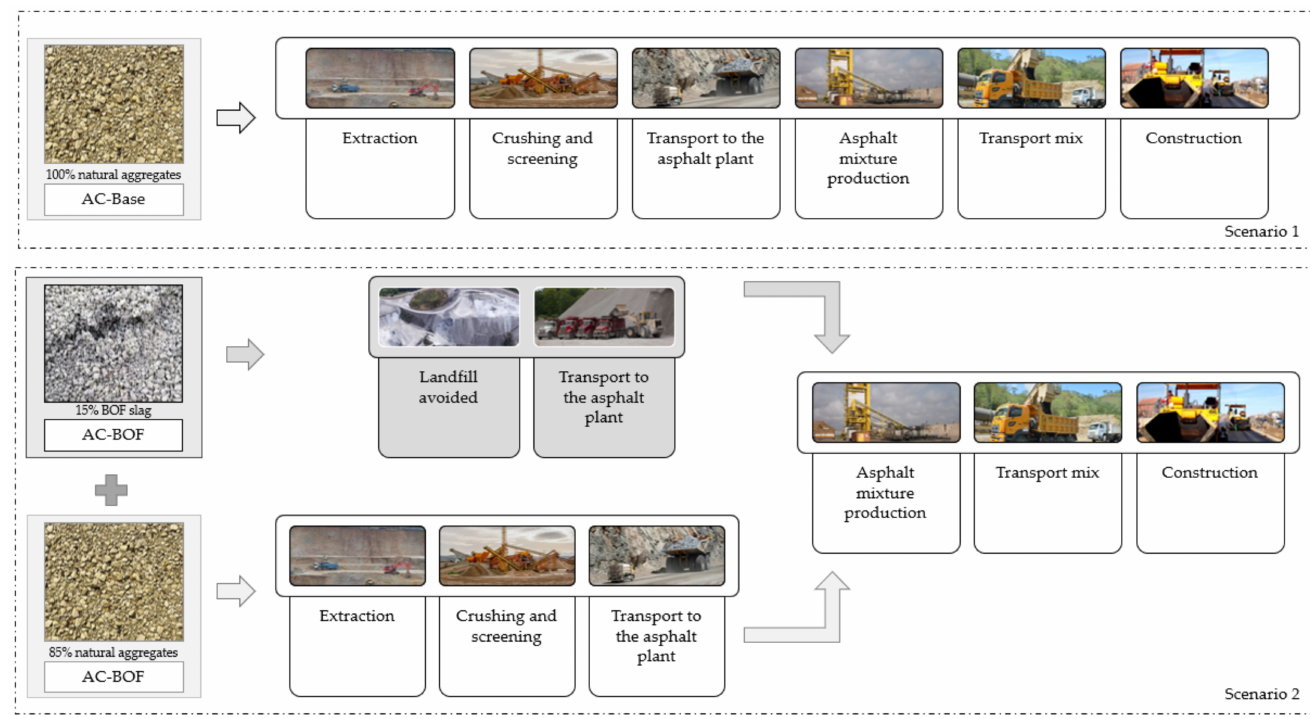
Figure 3. Description of the system boundaries in both scenarios (AC-Base: mix with natural aggregates; AC-BOF: mix with BOF